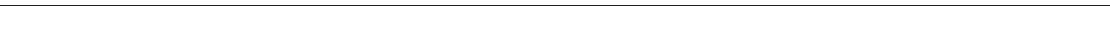
Fig. 3 Internalized TSH/TSHRs activate the G s -protein at the retromer-coated compartment (RCC) associated with the TGN. Primary mouse thyroid cells were co-transfected with different combinations of Nb37-YFP (or -SNAP) and subcellular markers, followed by stimulation with fl uorescent TSH (TSH-594 or TSH-647) for 10 min. a Recruitment of Nb37 to tubulovesicular structures containing internalized fl uorescent TSH-594 at 10 and 30 min. b Quanti fi cation of the effect of TSH stimulation on the number of Nb37-positive (Nb37 + ) structures over time. Reported is the percent change (mean ± s.e.m.; n = 5/5 cells) over basal with or without (control) dynasore pretreatment (30 min). Differences at individual time points were compared using the Holm – Š ídák test for multiple comparisons (black dots, P values). c Transient membrane recruitment of Nb37-YFP upon arrival of TSH-594- carrying vesicles. Top, Two consecutive images of a time series showing an increase of the Nb37-YFP signal upon arrival of a TSH-carrying vesicle. Bottom, Kymograph of the above time series generated along the indicated white line , showing two consecutive events of Nb37 recruitment (arrowheads). d Quantitative analysis of events like those shown in c (mean ± s.e.m.; n = 30). **** P < 0.0001 by Student ’ s t -test compared to intensity immediately before the event. ns, statistically non-signi fi cant. Note that while the Nb37 intensity increased, the TSH-594 intensity did not change, ruling out artefacts due to movements along the z -axis. e Representative image of an Nb37-postive membranous structure, showing the asymmetrical localization of TSH-647, Nb37-YFP and Vps29-mCherry, used to visualize the retromer complex. f , g Simultaneous visualization of TSH-594, Nb37-SNAP labeled with SiR (Nb37- SiR) and Rab5-GFP or Rab11-GFP, showing lack of triple co-localization. h Simultaneous visualization of TSH-647, Nb37-YFP and the TGN marker ST-RFP. The insets show examples of Nb37 recruitment on both ST-RFP-positive and negative structures. i Quanti fi cation showing the percentage (mean ± s.e.m.; n = 15 cells) of TSH-containing structures co-localizing with Nb37-YFP and ST-RFP over time. j Schematic view of the results. Where appropriate, cell edges and nucleus (N) are marked in white. Data in a , e – h are representative of 4, 3, 3, 3 and 5 independent experiments,